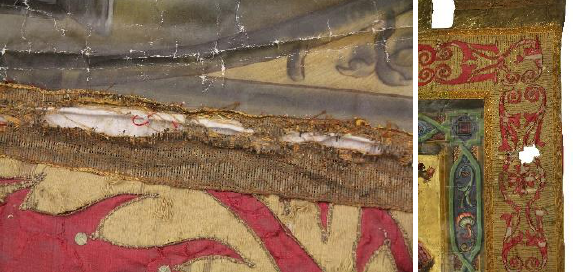
Figure 11 – Examples of tears on fabric elements on banners S. Adrião (left) and Pescadores (right)